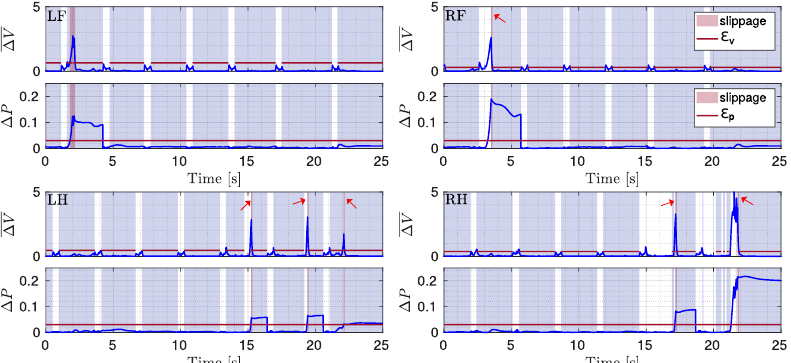
Figure 5. Simulation of the HyQ robot traversing slippery terrain patches with a crawl gait (low friction patches illustrated in white). The image sequence starts from the top left to right and continues at the bottom left. The red arrows indicate slipping feet.